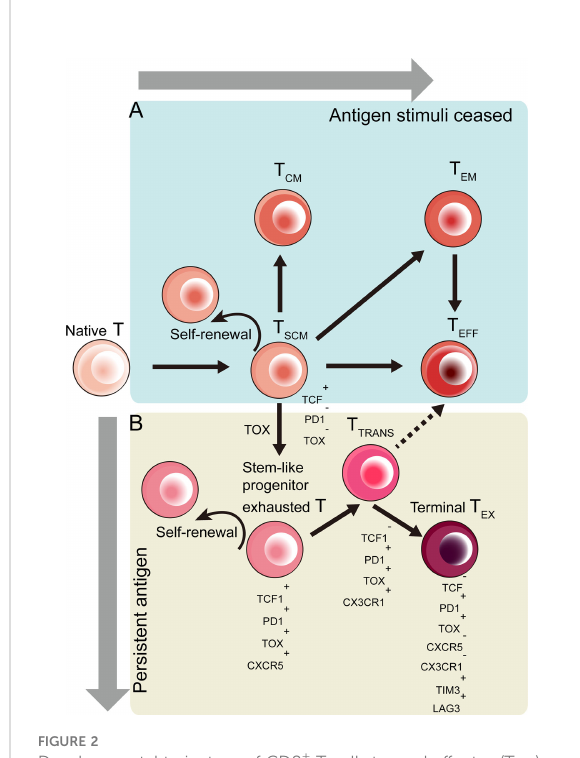
FIGURE 2 Developmental trajectory of CD8 + T cells toward effector (T EFF ) and exhausted (T EX ) CD8+ T cells in response to different antigen stimulation conditions. Stem-like T cells emerge during the T cell differentiation. (A) When antigen clear and stimuli cease, activated T cells differentiate into memory stem cell-like T cells (T SCM ), central memory (T CM ) T cells or effector memory (T EM ) T cells in terms of signal strength (51). (B) Induced by TOX- based epigenetic regulation, T SCM cells become stem-like progenitor exhausted T cells co-expressed TCF1, PD1, TOX and CXCR5. These stem-like exhausted T cells then become TCF1 - PD1 + TOX + CX3CR1 + transitory exhausted T (T TRANS ) cells, which give rise to terminally exhausted (T EX ) T cells (52 –